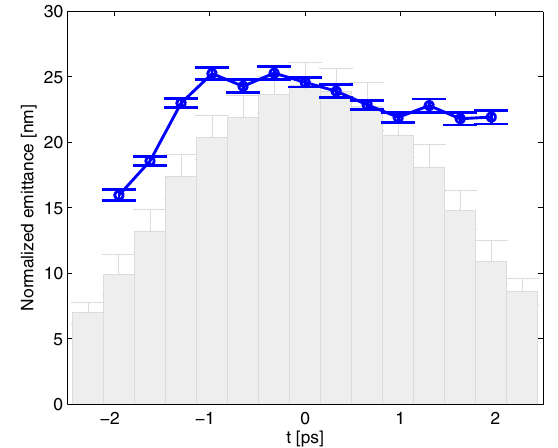
FIG. 10. Same as Fig. 9 for a bunch charge of 200 pC.